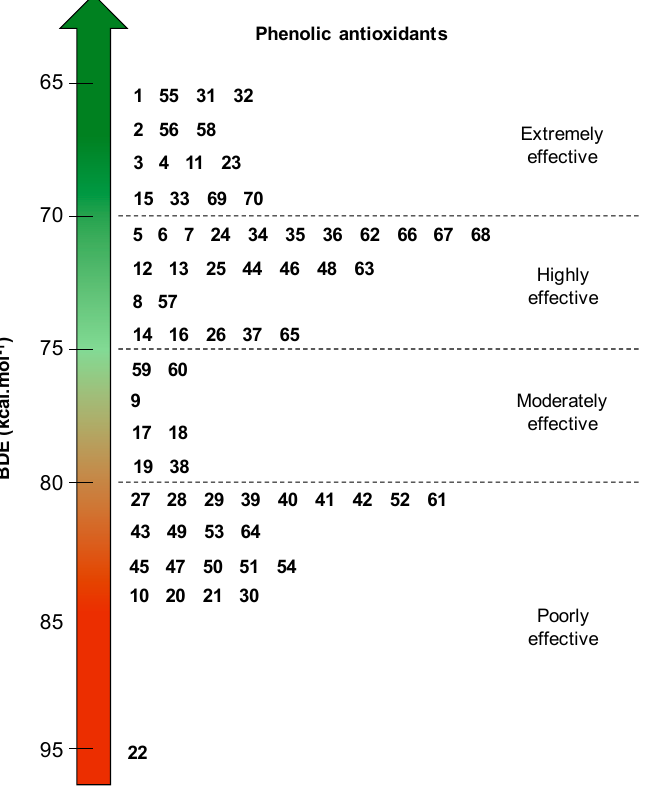
Figure 12. Scale of expected effectiveness of all the phenolic antioxidants studied ( 1 – 70 ) according to their BDE calculated with B3LYP/6-311++G(2d,2p)//B3LYP/6-311G(d,p) DFT method in vacuum. Very low BDEs (<70 kcal ¨ mol ´ 1 ) have been obtained for 5- tert -butylpyrogallol 1 , myricetin 32 , propyl gallate 4 and Gallic acid 15 , which are pyrogallol derivatives. This class contains also α -tocopherol 11 with a BDE of 69.1 kcal ¨ mol ´ 1 . Rosmarinic acid 23 , carnosol 69 and carnosic acid